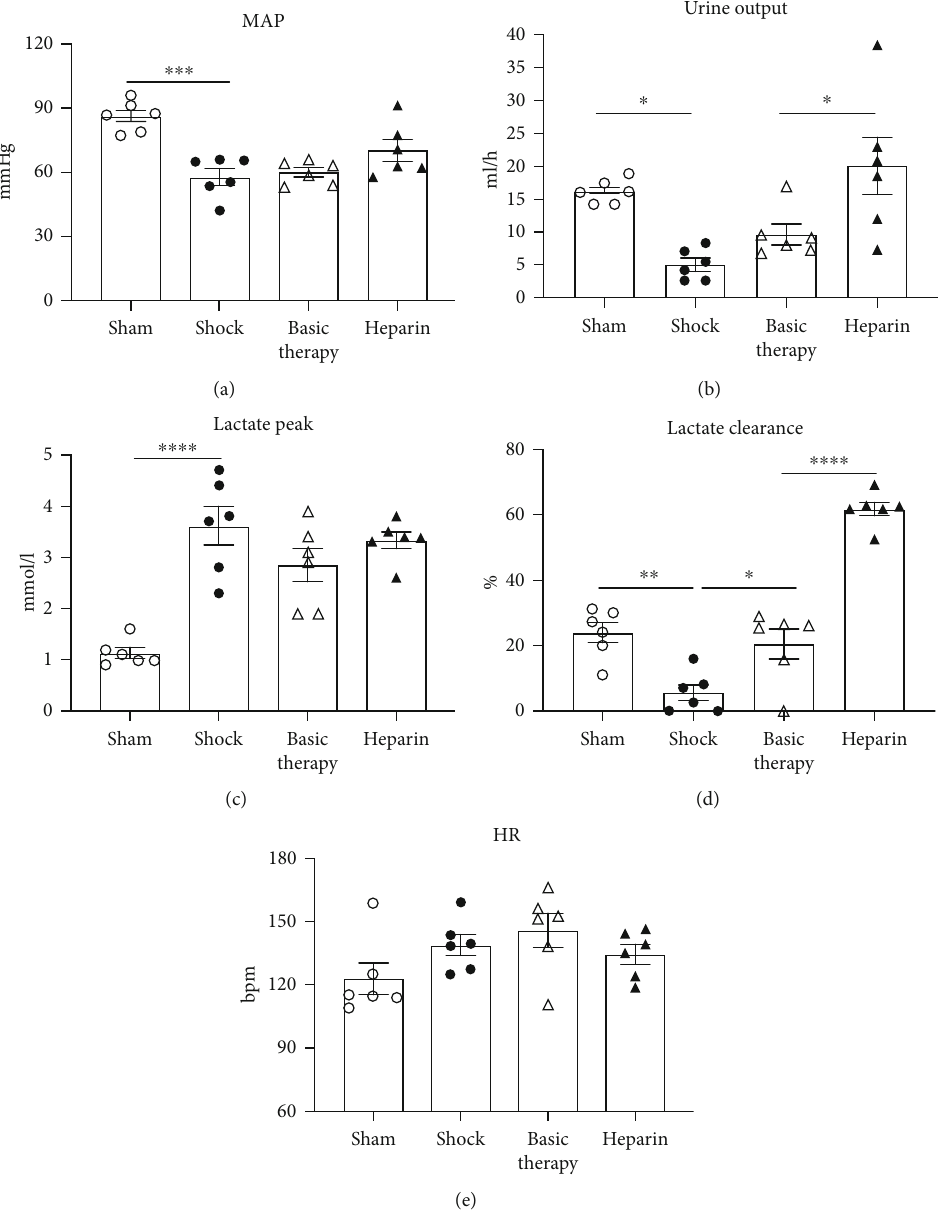
Figure 5: The e ff ect of UFH on basic physiology index in septic shock. The parameters were represented as the average values of MAP, UO, the lactate level, and HR from T0 to T24. ∗ P < 0 : 05 ; ∗∗ P < 0 : 01 ; ∗∗∗ P < 0 : 001 ; ∗∗∗∗ P < 0 : 0001